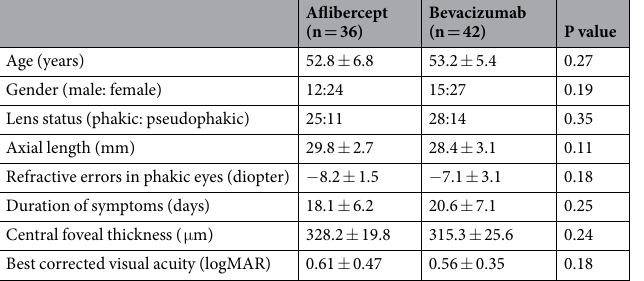
Table 1. Comparison of baseline data between intravitreal aflibercept and bevacizumab for myopic choroidal